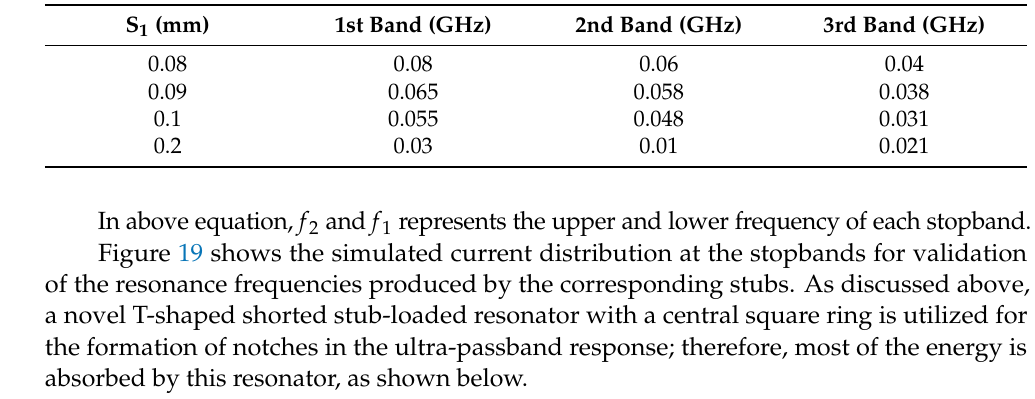
Figure 18. Coupling phenomena with respect to the parameter S. Table 5. Simulated result of “K” for different values of S.